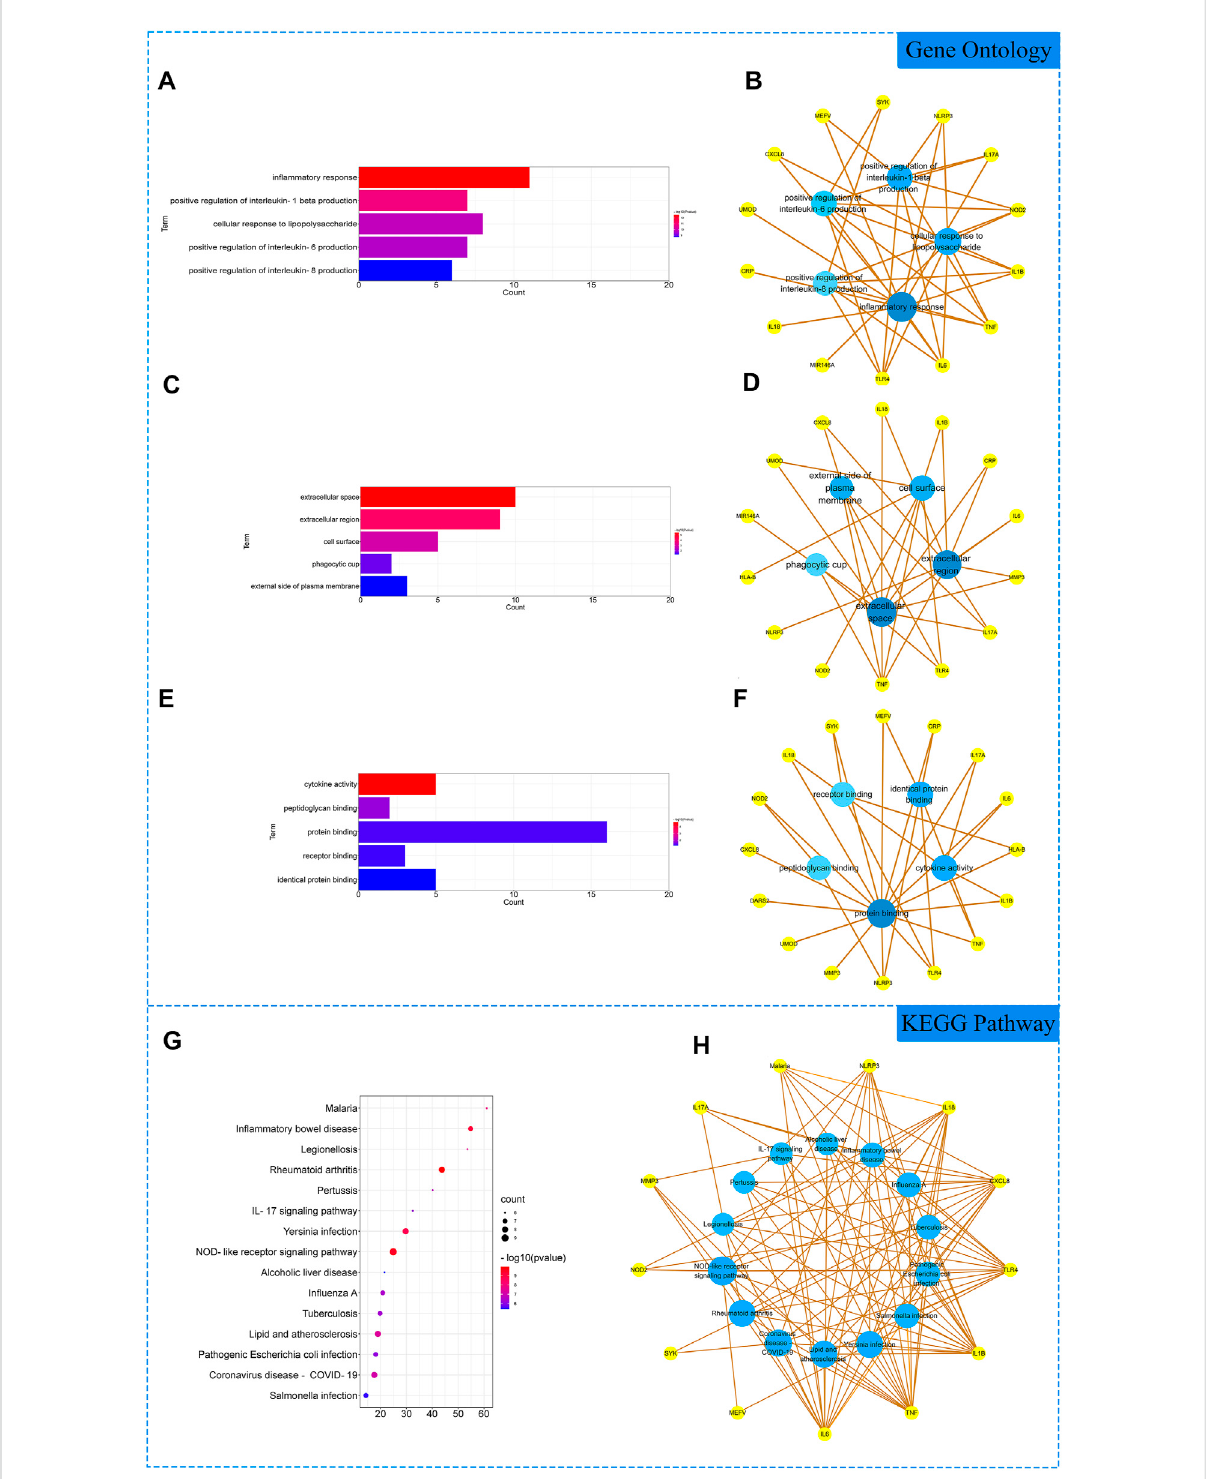
FIGURE 2 Gene Ontology (GO) and Kyoto Encyclopedia of Genes and Genomes (KEGG). Analysis of related genes. (A) The top 5 terms in biological processes(BP)weregreatlyenriched. (B) Thesubnetworkdisplayedthetop5BPtermsandrelatedgenes. (C) Thetop5termsincellularcomponents (CC)were greatly enriched. (D) Thesubnetworkdisplayed thetop 5CCtermsand related genes. (E) Thetop 5termsinmolecularfunction (MF)were greatly enriched. (F) The subnetwork displayed the top 5 MF terms and related genes. (G) The top 15 KEGG pathways were showed. (H) The subnetworks displayed the top 15 KEGG